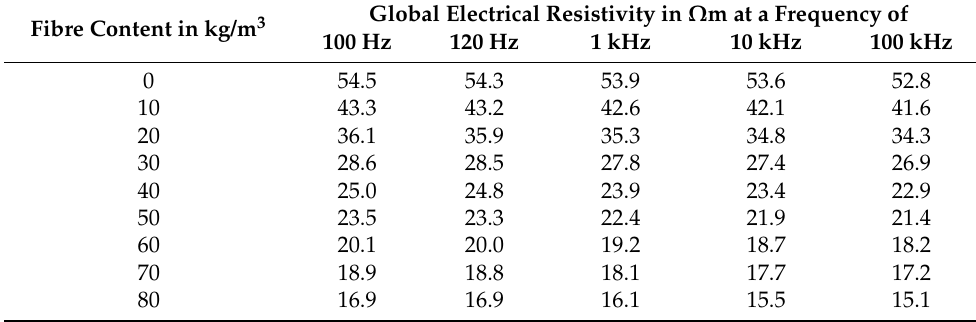
Table A18. Results of the resistivity measurements of the concrete mixture 32-60-300-65. Fibre Content in kg/m 3